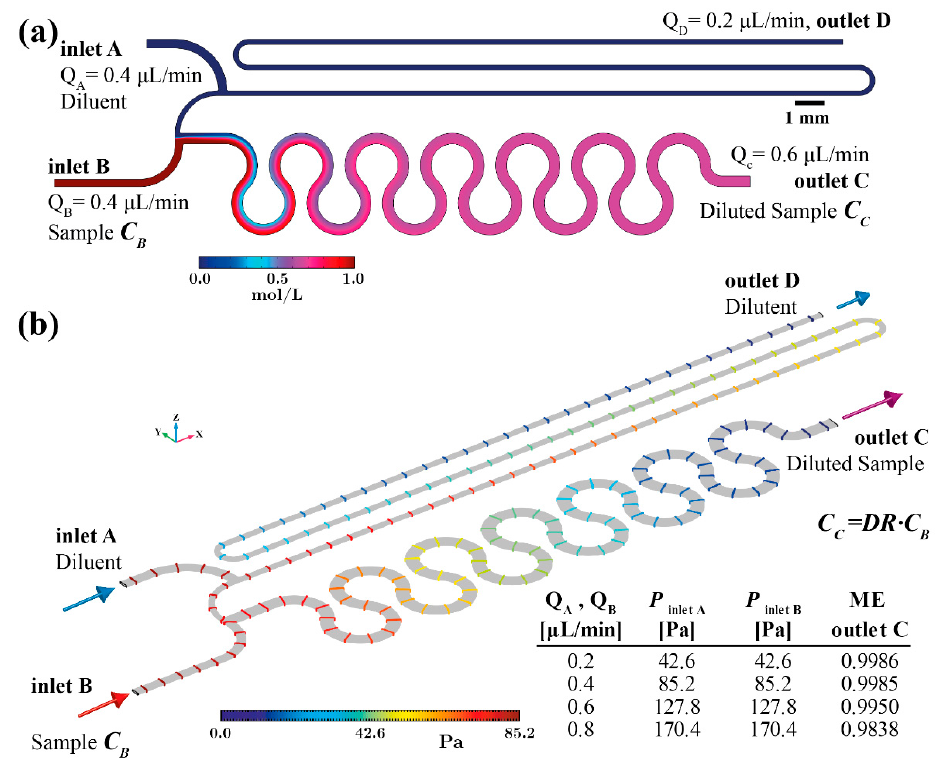
Figure 3. Pressure and flow rate balanced unit cell simulation results ( a ) concentration field overview on the device symmetry x - y plane ( z = 32 µ m) ( b ) iso-pressure lines overview in case of inlet flow rate 0.4 µ L/min and DR 2:3.